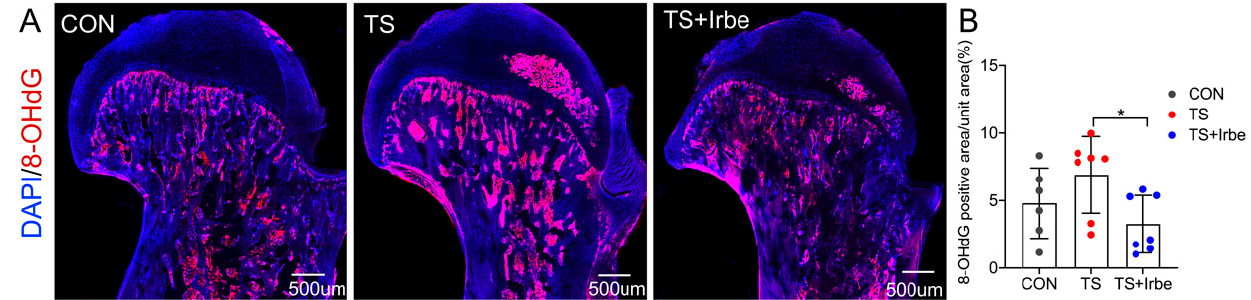
Figure 2. Irbesartan can inhibit reactive oxygen species in bone matrix after tail suspension. ( A ) Representative images of 8-OHdG immunofluorescence staining (red), Nuclei was stained with DAPI (blue). ( B ) 8-OHdG positive area per unit area (%). * p < 0.05.